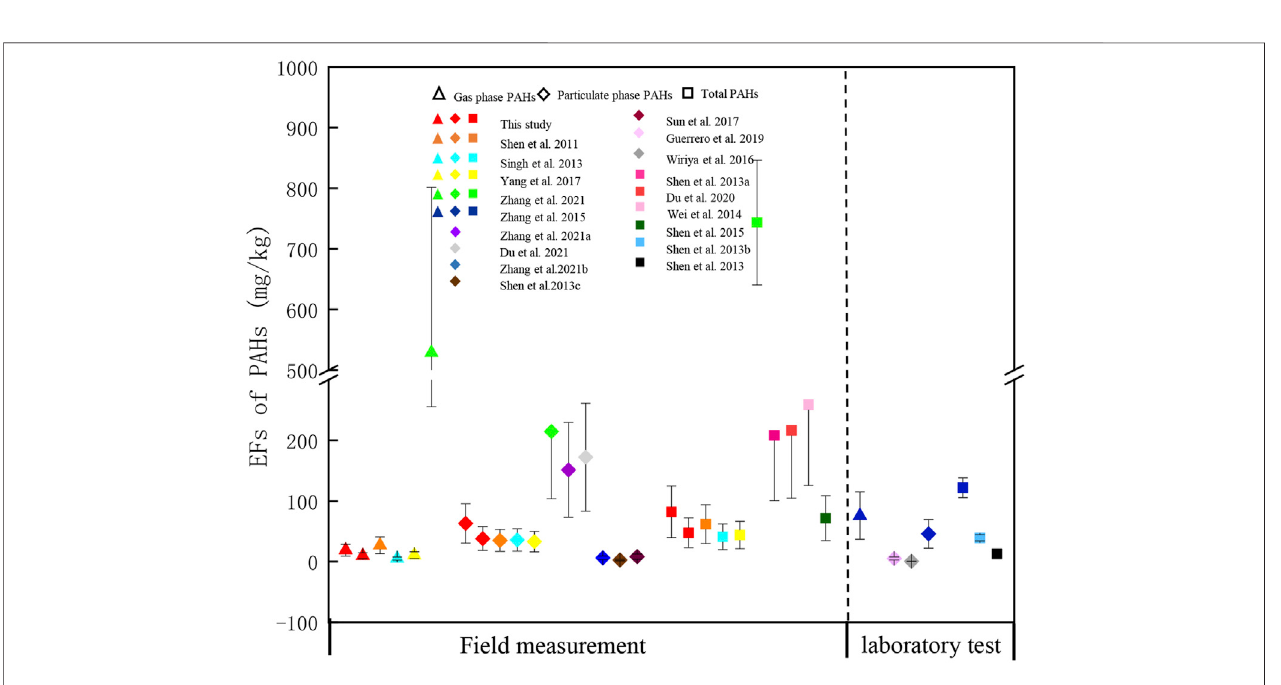
FIGURE 4 | Comparison of PAH EFs in existing